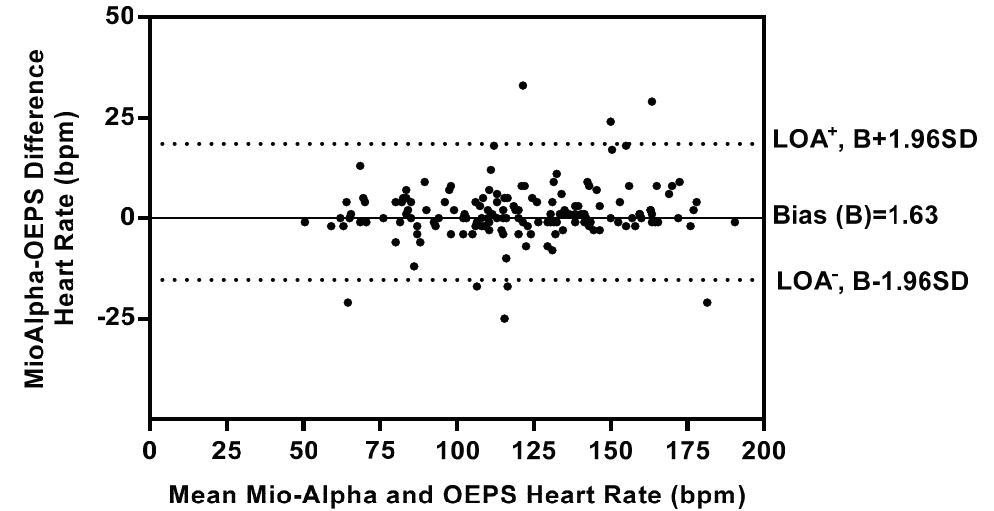
Figure 20. Bland-Altman plot shows differences in HR outputs recorded at rest and during differing exercise modalities and intensities using Mio-Alpha and the OEPS. Mean bias (solid line) and limits of agreement (dashed line).